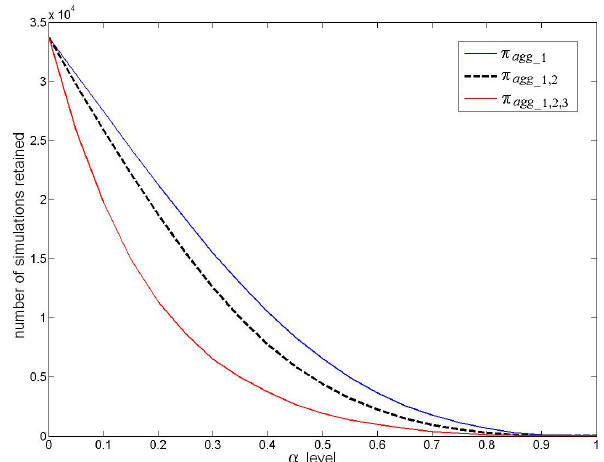
Fig. 3. Total number of simulations retained above different possi- bility levels α of the possibility distributions π agg 1 , π agg 1 , 2 and π agg 1 , 2 , 3